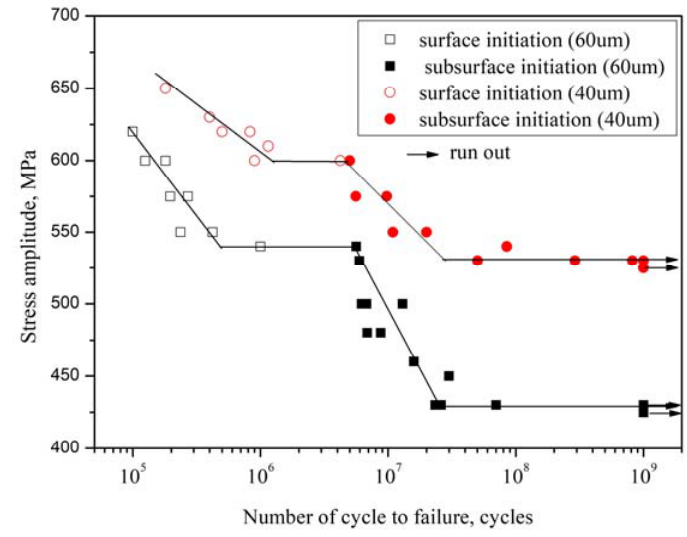
Figure 3. S ‐ N curve of TC21 titanium alloy with two sizes of basketweave.